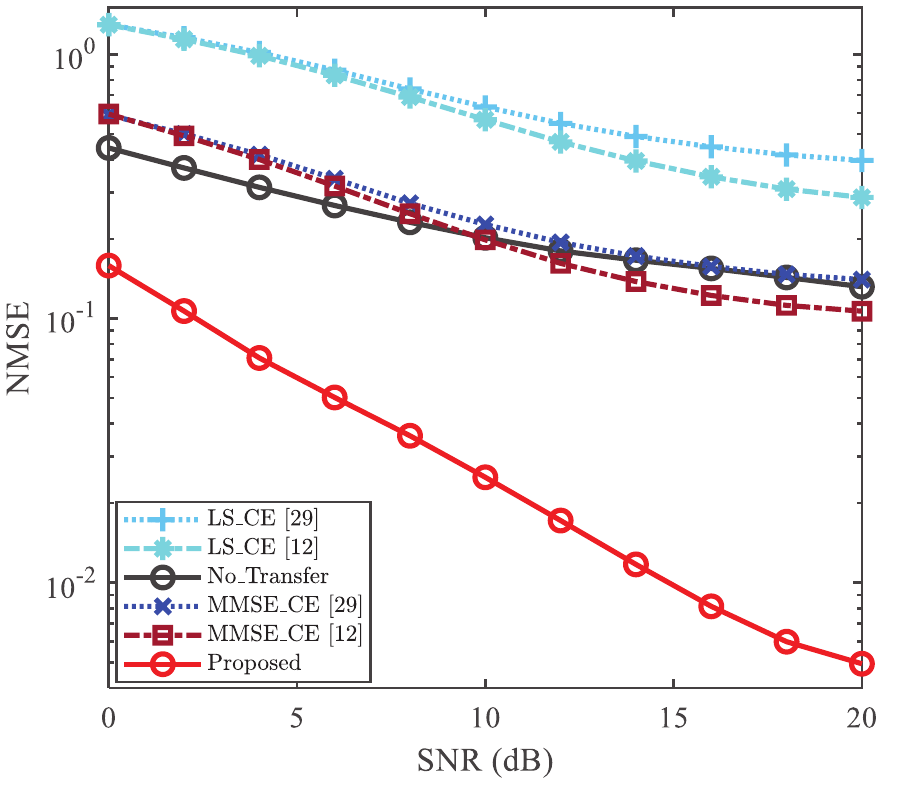
Fig 3. NMSE vs. SNR, where N = 256, L = 8, P = 8, and ρ =